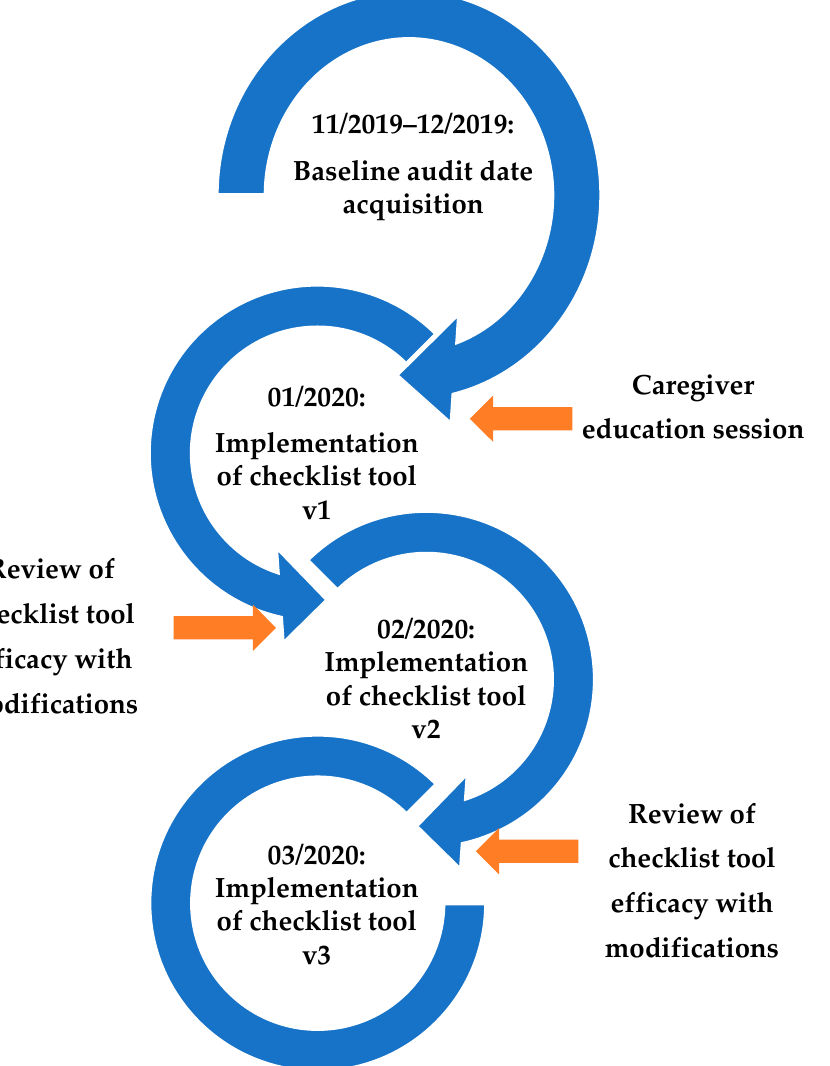
Figure 2. Plan–Do–Study–Act (PDSA) cycle workflow. With each successive PDSA cycle, the RN champions for our study provided feedback to the study team regarding the efficiency and practicality of the rounding checklists. Each PDSA cycle was designated as 1 month in duration. Checklist revisions were made based upon feedback after each cycle. v1 = Version 1. v2 = Version 2. v3 = Version 3.